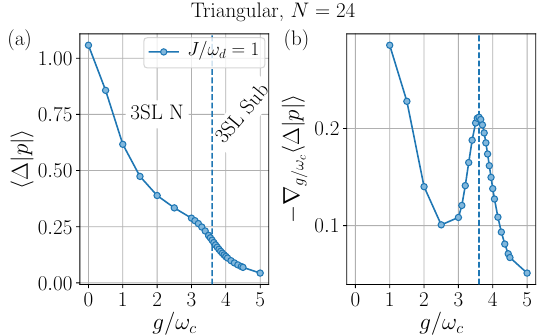
Figure 10: Crossover between the normal 3SL and subradiant 3SL regimes. The polarization fluctuations (a), and their gradient with respect to g /ω = 1. The crossover boundary is estimated by a sharp drop in the for constant J /ω d fluctuations 〈 ∆ | p |〉 , where the polarization distribution becomes strongly pinned to = 0. As shown in the right panel, we compute the boundary the single value S x position by a peak in the negative gradient of 〈 ∆ | p |〉 with respect to the external parameter g /ω (indicated by the dashed vertical c